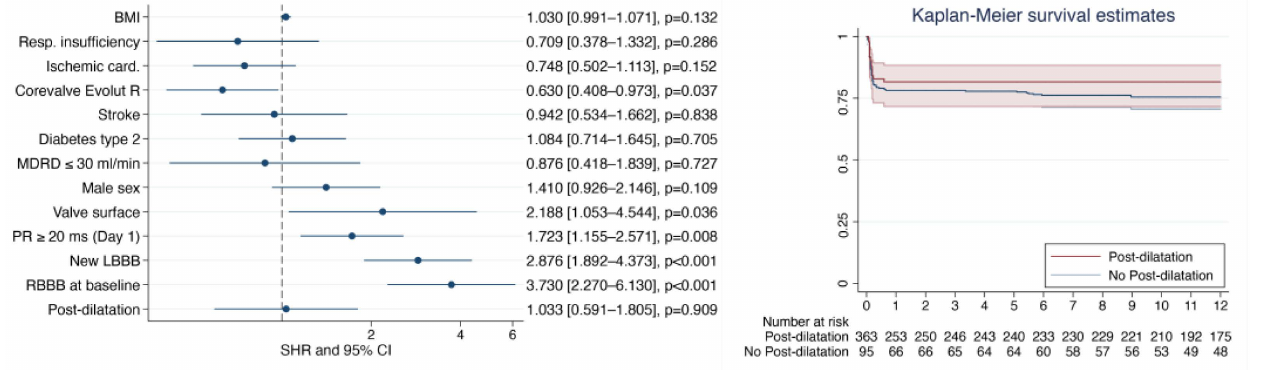
Figure 2. Multivariate analysis adjusted on mortality and previous pacemaker implantation ( left ), and Kaplan–Meier survival curve without a pacemaker implanted for high-grade conduction disorder ( right ). BMI: indexed body mass index; Resp. insufficiency: respiratory insufficiency; LBBB: left bundle branch block; RBBB: right bundle branch block.